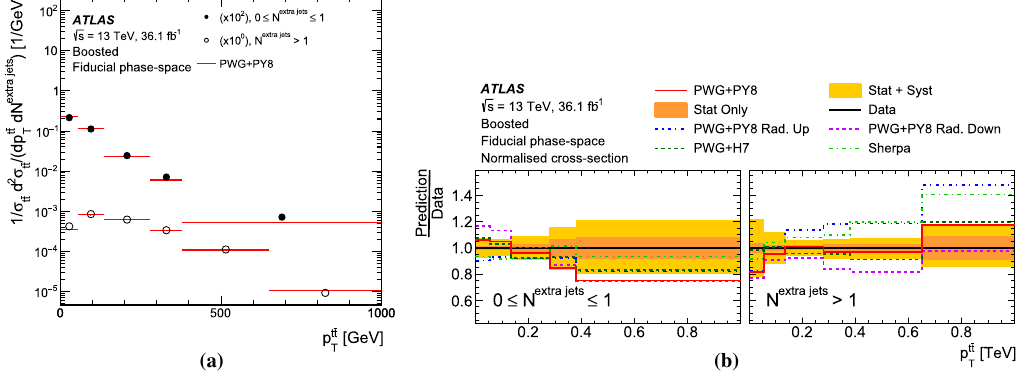
tre of each bin. b The ratio of the measured cross-section to different Monte Carlo predictions. The bands represent the statistical and total